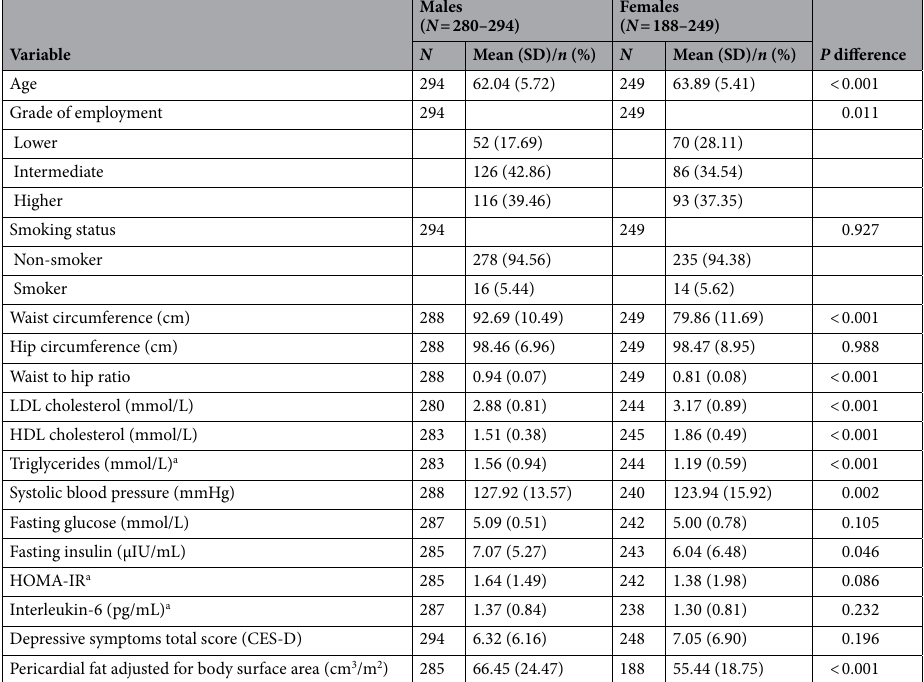
Table 1. Participant characteristics at baseline, stratified by sex (observed data). a Variable was log